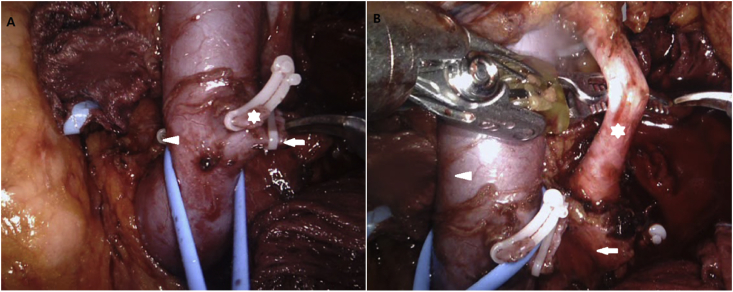
(A) Mobilization of the left hilar vessels (gonadal vein; white star, adrenal vein; white arrowhead, lumbar vein; white arrow). (B) The maxillary length of the renal artery and vein as much as possible (renal artery; white star, aorta; white arrow, renal vein; white arrowhead).